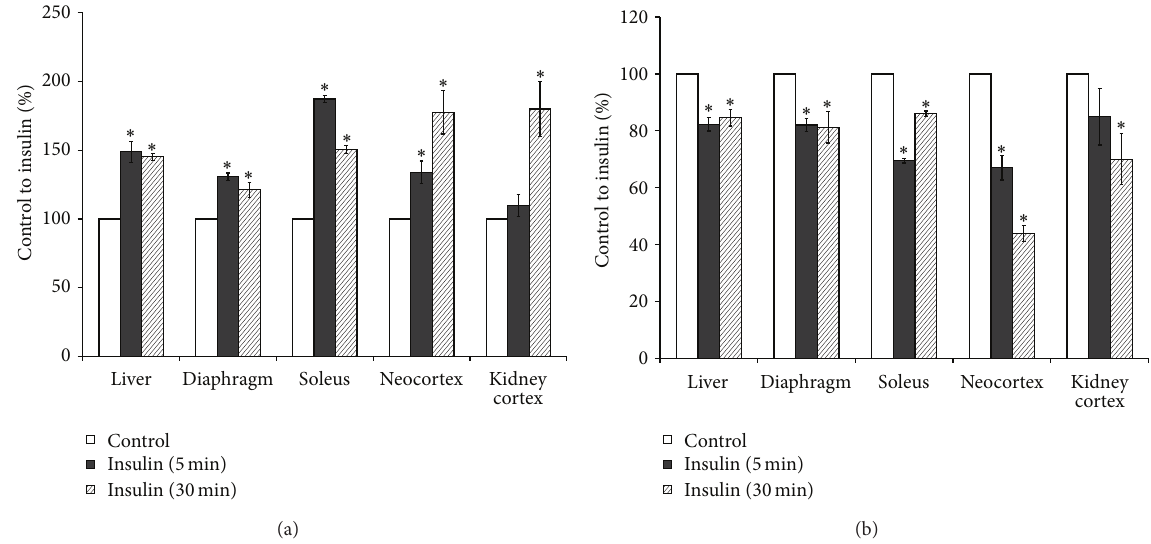
Figure 1: Effect of insulin on phospholipase D activity in rat tissues slices. (a) [ 14 C]phosphatidylethanol, (b) [ 14 C]phosphatidylcholine. Formation of [ 14 C]phosphatidylethanol and degradation of substratum of phospholipase D, [ 14 C]phosphatidylcholine in the presence of 300 mM ethanol and 10nM insulin was determined as described in the Methods. ∗ 𝑝 < 0.05 , insulin versus control.